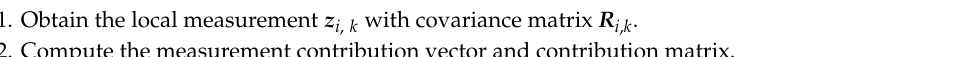
Algorithm 1. DHIWCF implemented by node i at time instant k